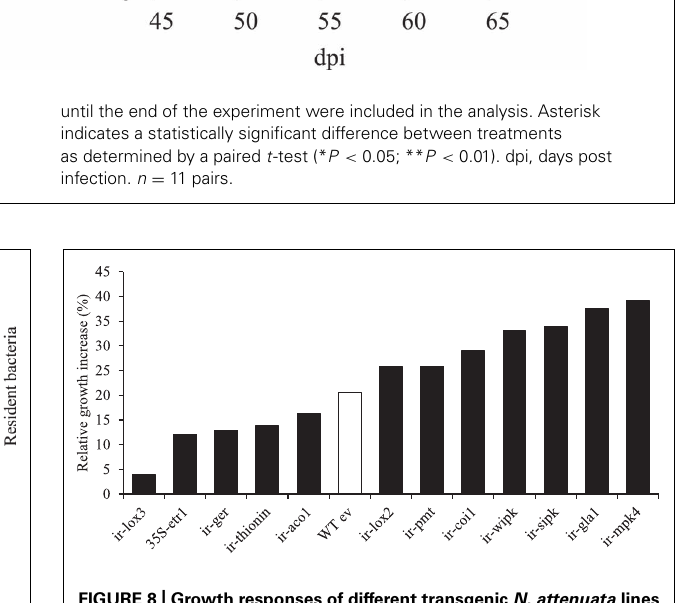
FIGURE 8 | Growth responses of different transgenic N. attenuata lines to a B55 inoculation. Relative B55-associated growth increase of different transgenic N. attenuata lines compared to non-inoculated plants.Twenty day old plants were inoculated with B55 or mock-inoculated (late-stage inoculation). Size of the longest leaf was measured on the day of inoculation and at the end of the experiment (12 or 14 dpi). Growth increase (%) of B55-inoculated plants was calculated relative to non-inoculated plants. See Table 2 for abbreviations of genes silenced by RNAi by expression of inverted repeat (ir) constructs in the transformed lines. dpi, days post infection. n =